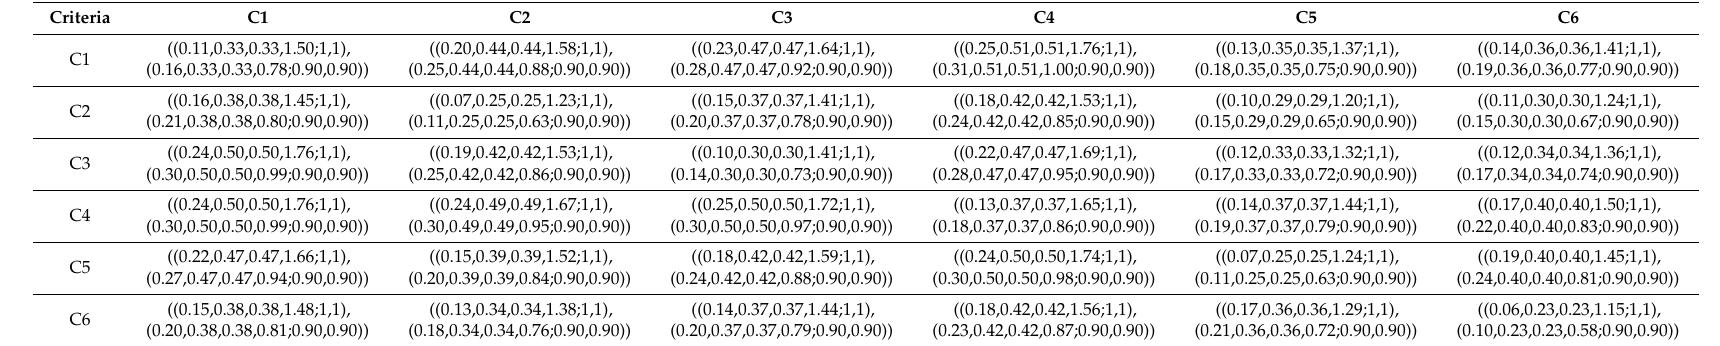
Table 8. Total relation